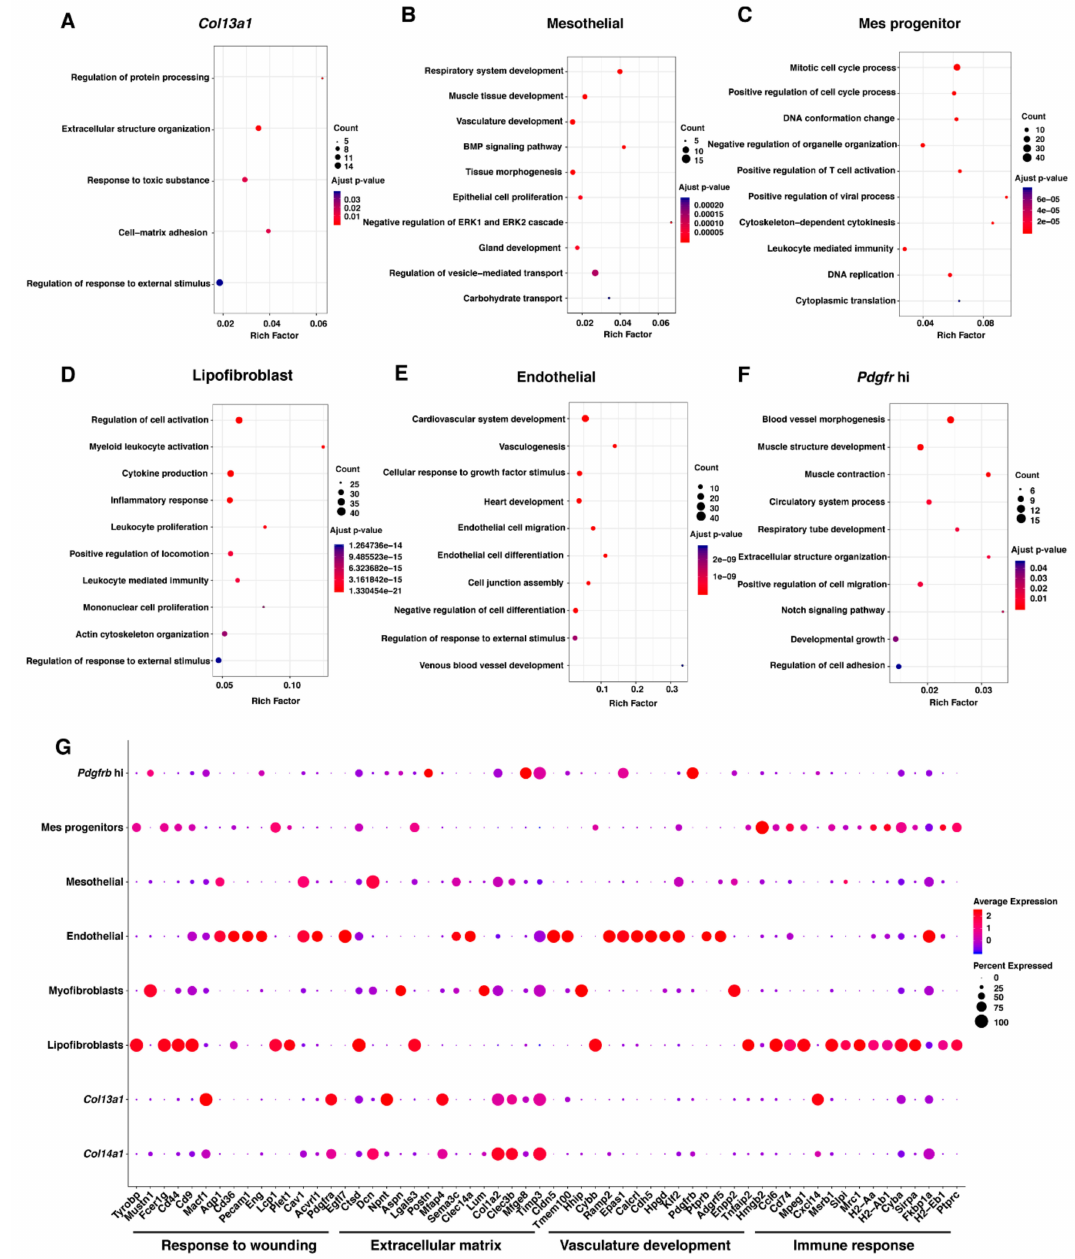
Figure 5. GO enrichment analysis of the di ff erentially expressed genes in each cell type to predict the role of the di ff erent mesenchymal cell types. ( A – F ) Functional enrichment analysis with GO Biological Processes was performed using Metascape with all di ff erentially expressed biomarkers in each cell population. Dot size represents the number of genes involved in the process, and dot color represents the adjusted p -value of the process, as described in the key. ( G ) Expression of selected genes involved in response to wounding, extracellular matrix, vasculature development and immune response in Pdgfrb hi, mes progenitors, mesothelial, endothelial, myofibroblasts, lipofibroblasts, Col13a1 and Col14a1 matrix cells. Dot size represented the percentage of cells in the cell population expressing a gene, and dot color represents the average expression level for the gene in the cell population as described by the